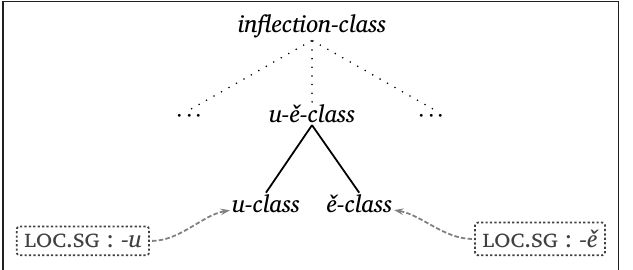
Figure 5 Overabundant classes as joins in an inflection class hierarchy (Bonami & Crysmann 2018).